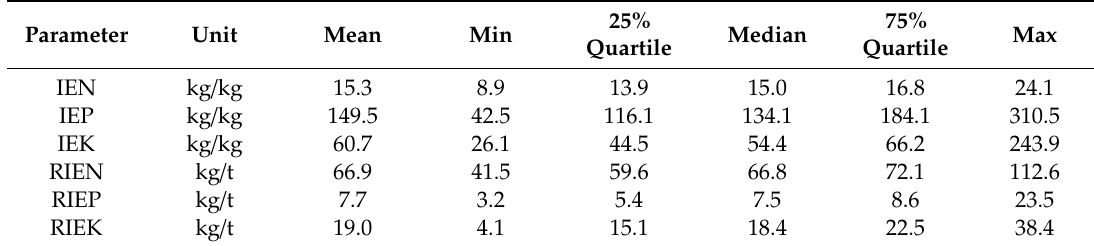
Table 2. Statistical characteristic of internal e ffi ciency (IE) and reciprocal internal e ffi ciency of nutrient for soybean in 29 experiment